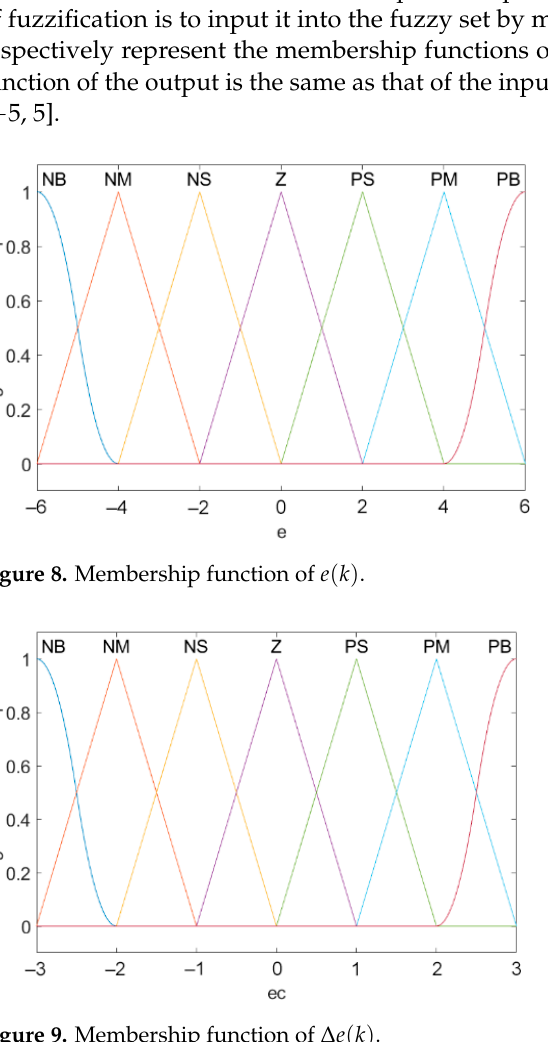
Figure 9. Membership function of ∆𝑒(𝑘) .